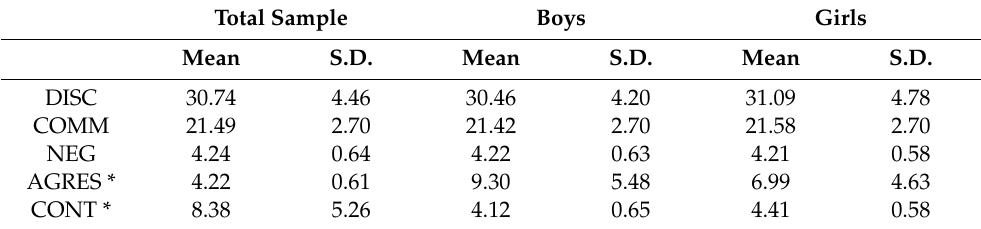
Table 3. Basic descriptive statistics in the total sample and by gender for the 3–6 year-old group. Total Sample